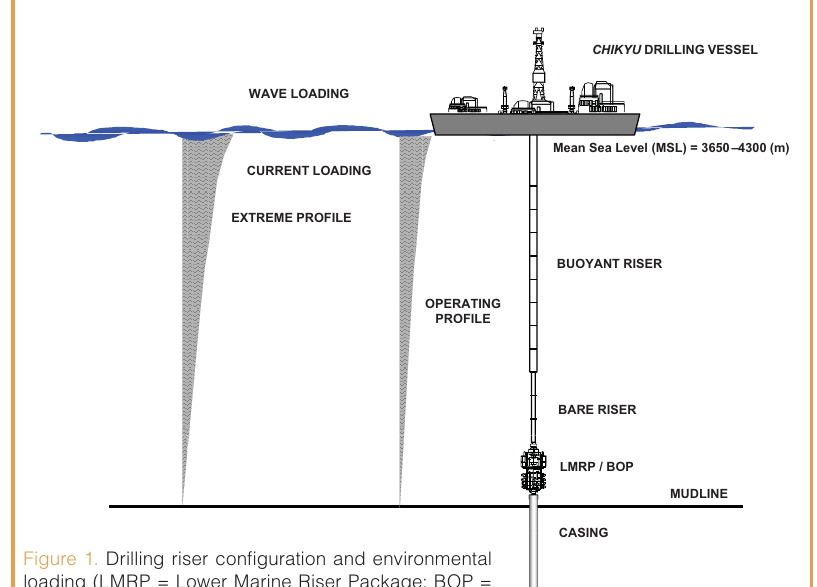
Figure 1. Drilling riser configuration and environmental loading (LMRP = Lower Marine Riser Package; BOP = Blowout